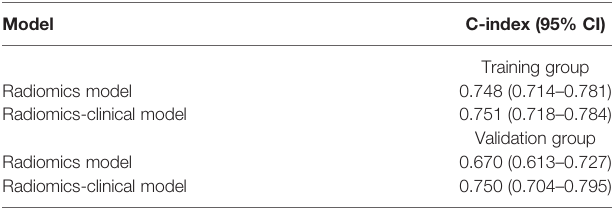
TABLE 5 | Performance of evaluating patients ’ RFS in different models of training groups and validation groups. Model